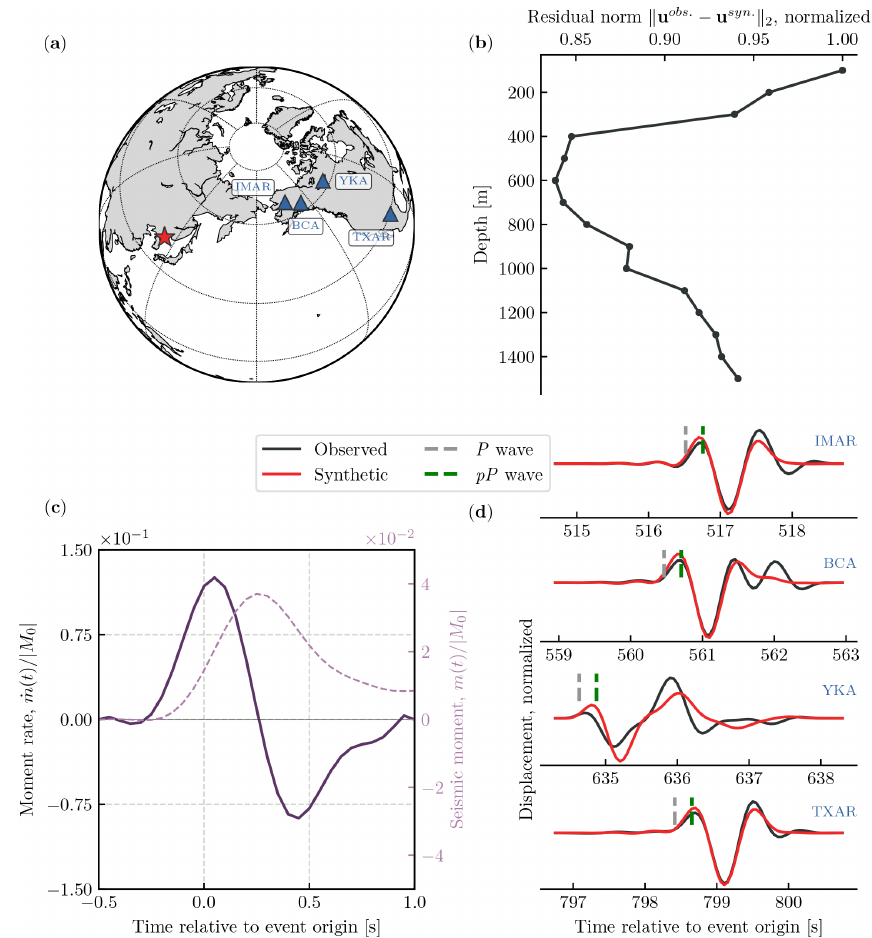
Figure 3. (a) Setup of the depth analysis with the 2017 North Korean nuclear test marked as a red star and the four small-aperture, short- period arrays marked as bluish triangles. The epicentral distances to arrays IMAR, BCA, YKA, and TXAR are 48 ◦ , 54 ◦ , 65 ◦ , and 94 ◦ , respectively. (b) Residuals between observed and synthetic waveforms ( L 2 norm) as a function of depth of the explosion. (c) Least squares source time function associated with the best-fit regularized solution. Solid and dashed lines are the normalized moment rate and moment function, respectively. (d) Observed (black) and synthetic (red) waveforms for the best-fit regularized solution at 600m depth. The gray and green dashed lines indicate the theoretical arrival times of the P and pP phases, respectively. The traces are bandpass-filtered between 0.5 and